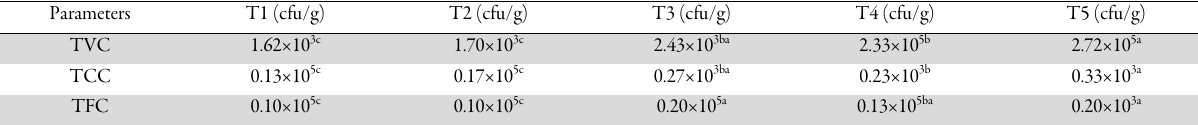
Table 7. Microbial properties of the fish carcass Parameters